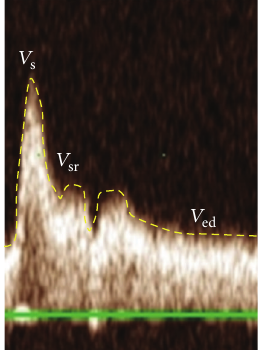
Figure2:SampleCCAflowvelocitywaveform. 𝑉 𝑠 :peaksystolicflow : secondary rise in the CCA flow velocity waveform; 𝑉 velocity; 𝑉 sr velocity during end